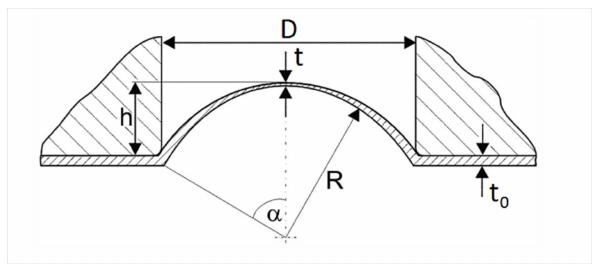
Figure 1: Scheme of the hydraulic bulge test